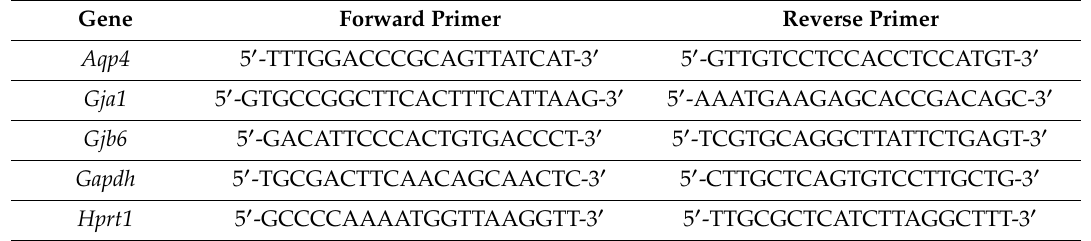
Table 2. PCR primers. The following primer pairs used in the